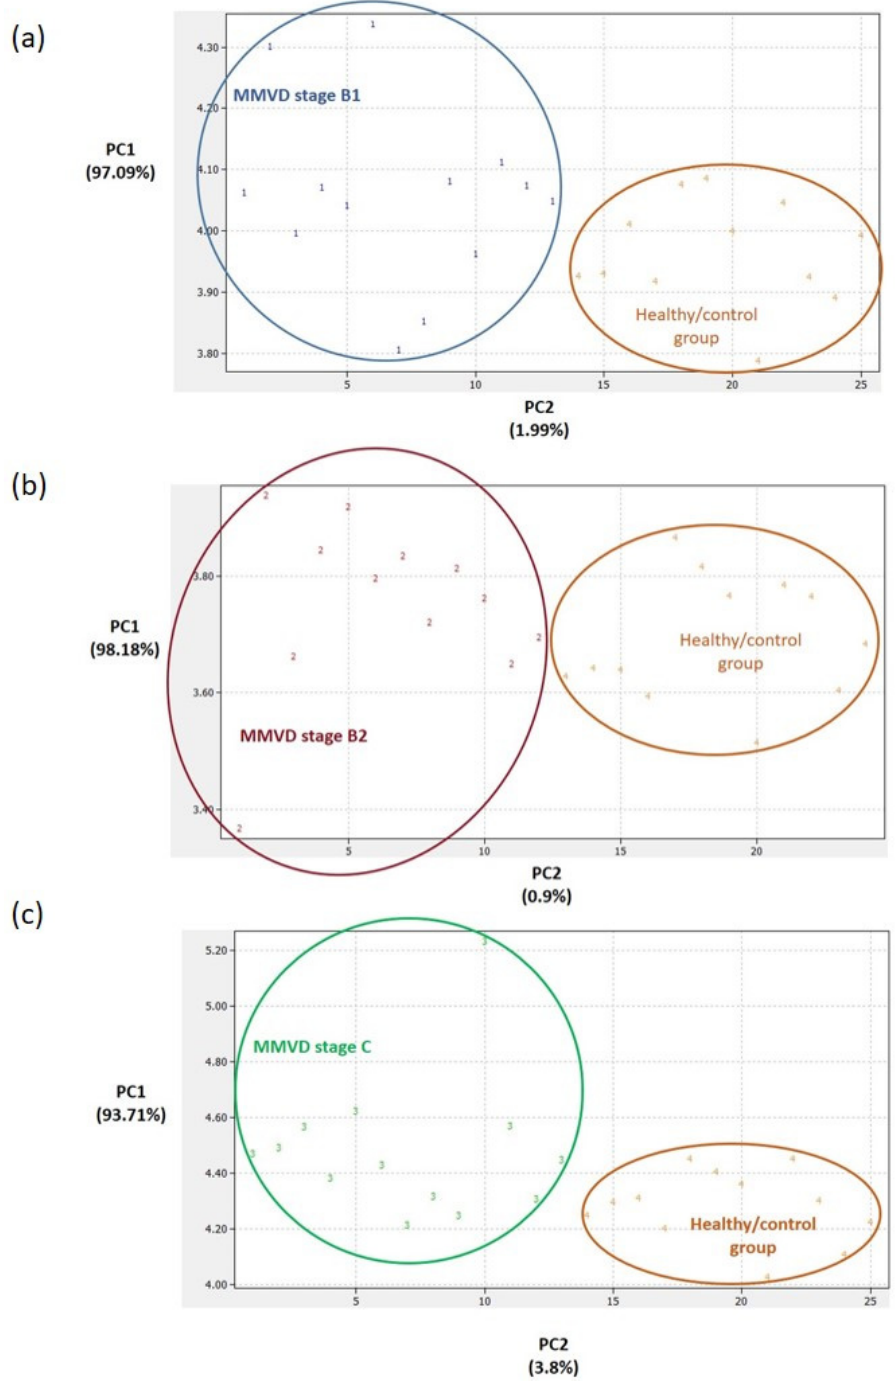
Figure 3. Principal component analysis (PCA) score plots. Clear differentiation between the healthy/control group and the groups with myxomatous mitral valve disease (MMVD) stages B1 ( a ), B2 ( b ), and C ( c ). In preparing the plots, relative abundance ratios of proteins with statistically different abundances (Figure 2) were used for the PCA. The PCA was performed in DataLab soft- ware. Class numbers: 1 = MMVD stage B1 (N = 13 biological replicates), 2 = MMVD stage B2 (N = 12 biological replicates), 3 = MMVD stage C (N = 13 biological replicates), and 4 = healthy/control group (N = 12 biological replicates). N represents the number of serum samples (biological replicates).